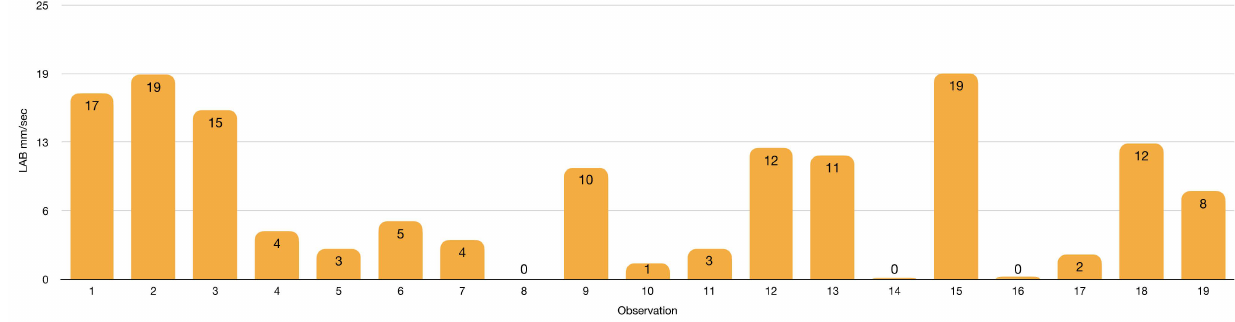
Figure 20. Zelus renardii speed in 9 cm Petri dish arena (details in Table